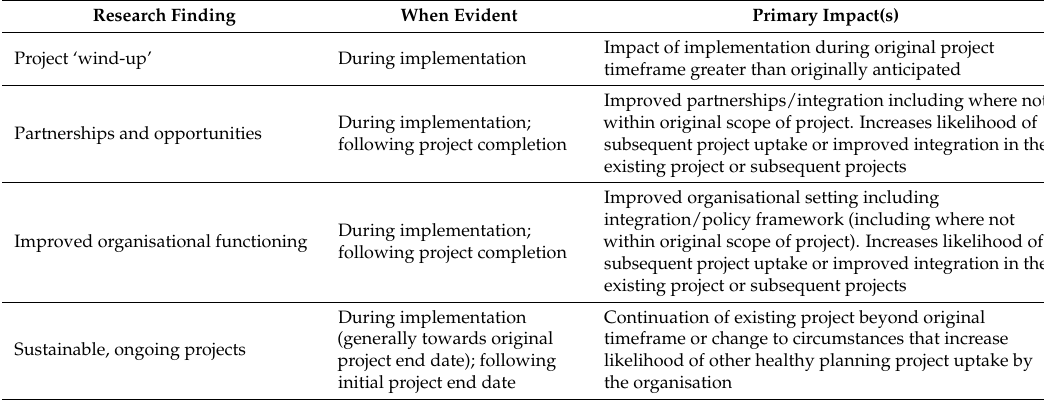
Table 1. Summary of four primary research